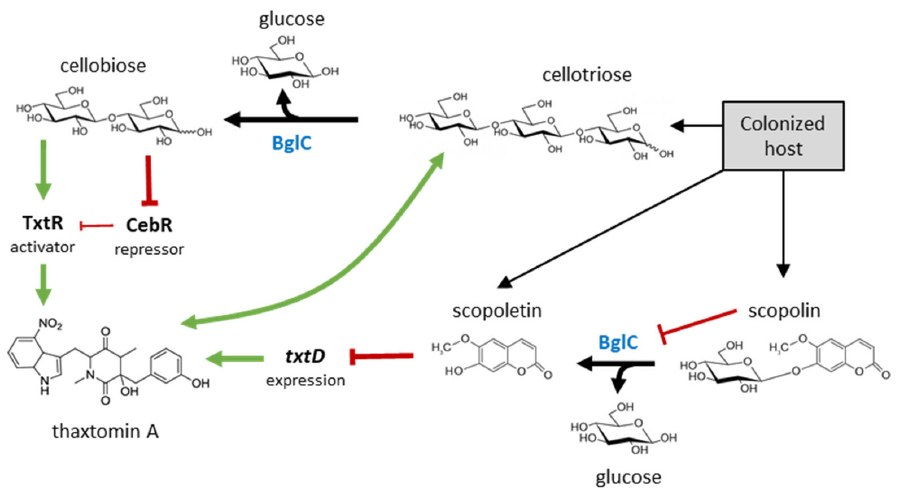
Figure 3. BglC-mediated fine-tuning of thaxtomin production in S . scabiei . Cellotriose emanating from expanding plant tissue triggers thaxtomin A production which in turn causes more release of cellotriose from the host [9]. Perception of thaxtomin A by the colonized host induces the production of the scopolin and scopoletin phytoalexins [15], the latter being a strong repressor of thaxtomin A production by reducing the expression of txtD (also called nos, scab31841 ) [15]. Hydrolysis of cellotriose by BglC generates cellobiose, the best allosteric effector of CebR—the repressor of the thaxtomin biosynthetic gene cluster—which also directly represses the expression of the thaxtomin pathway ‐ specific activator TxtR [12]. High concentrations of scopolin would inhibit the activity of BglC, resulting in (i) less accumulation of scopoletin (a thaxtomin A inhibitor) and (ii) limited degradation of cellotriose (the thaxtomin A inducer); both consequences are presumed to cause increased thaxtomin A production.